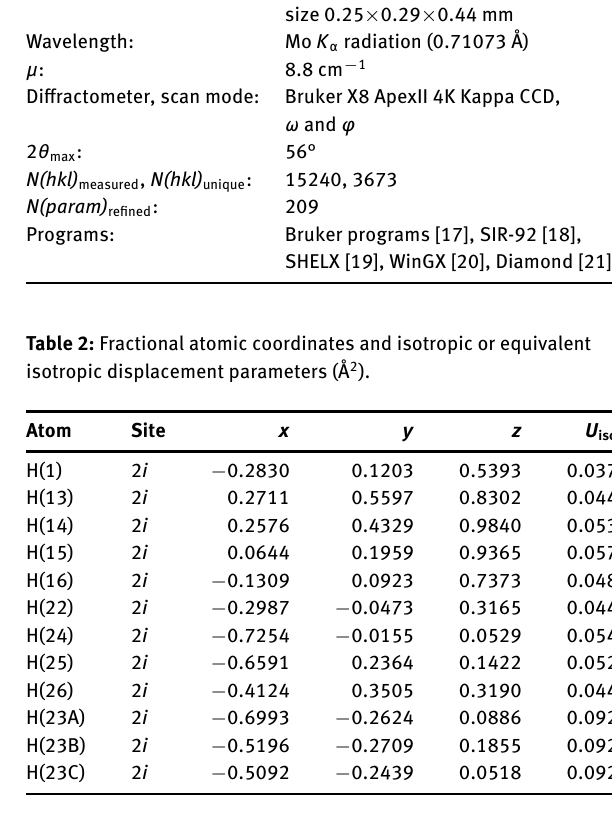
details of the measurement method and a list of the atoms including atomic coordinates and displacement